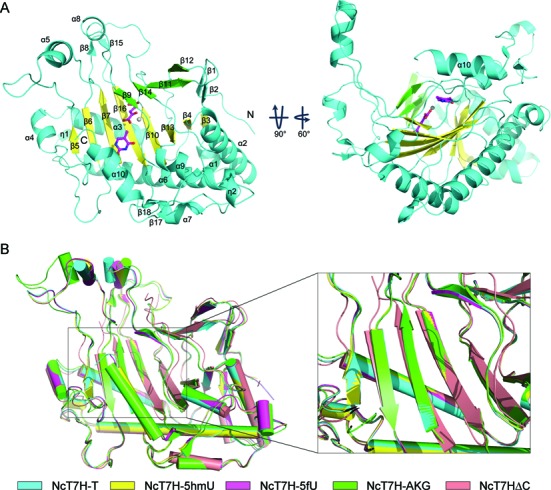
Overall structure of NcT7H. (A) Overall structure of NcT7H in complex with α-KG and T. The minor and major β-sheets that constitute the DSBH fold are coloured in green and yellow, respectively. Other structure elements flanking the DSBH core are shown in cyan. The location of the active site is indicated with a metal ion shown as a grey sphere, the cosubstrate α-KG and the substrate T shown as ball-and-stick models and coloured in magenta. The secondary structure elements are labeled. (B) Comparison of the overall structures of NcT7HΔC (salmon), NcT7H-AKG (green), NcT7H-T (cyan), NcT7H-5hmU (yellow) and NcT7H-5fU (magenta).